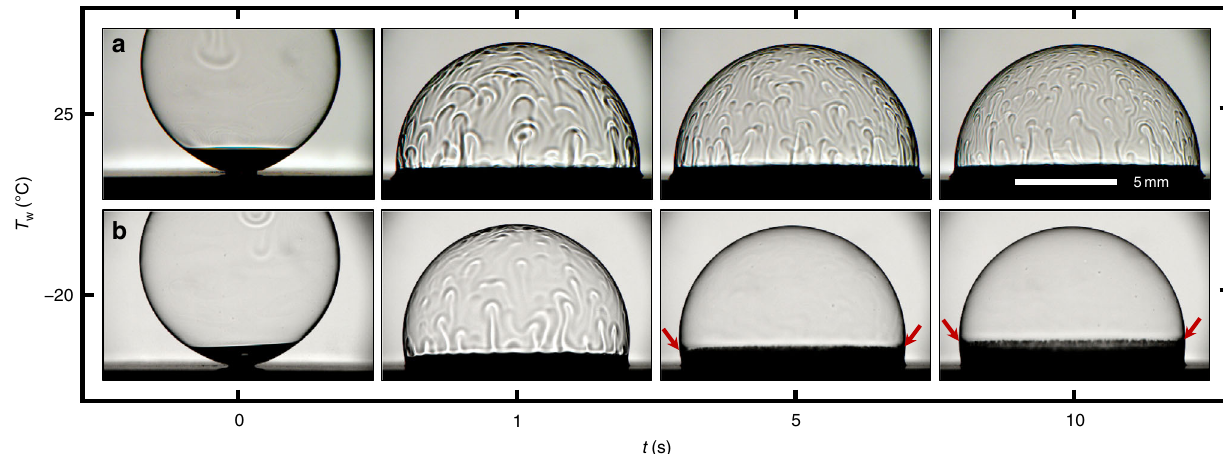
Fig. 3 Contrasting mechanisms for plumes in nonfreezing vs. freezing bubbles. a For a bubble deposited on a dry, room-temperature substrate, plumes were continually generated through the ~10-min lifetime of the bubble due to marginal regeneration. b For a bubble deposited on an icy cold stage ( T w = − 20 °C), the bottom-up freeze front (red arrows) suppressed marginal regeneration but enabled a brief (~1 s) fl ow due to Marangoni freezing. In either case here, the ambient conditions were T ∞ ≈ 25 °C with a relative humidity of RH ≈